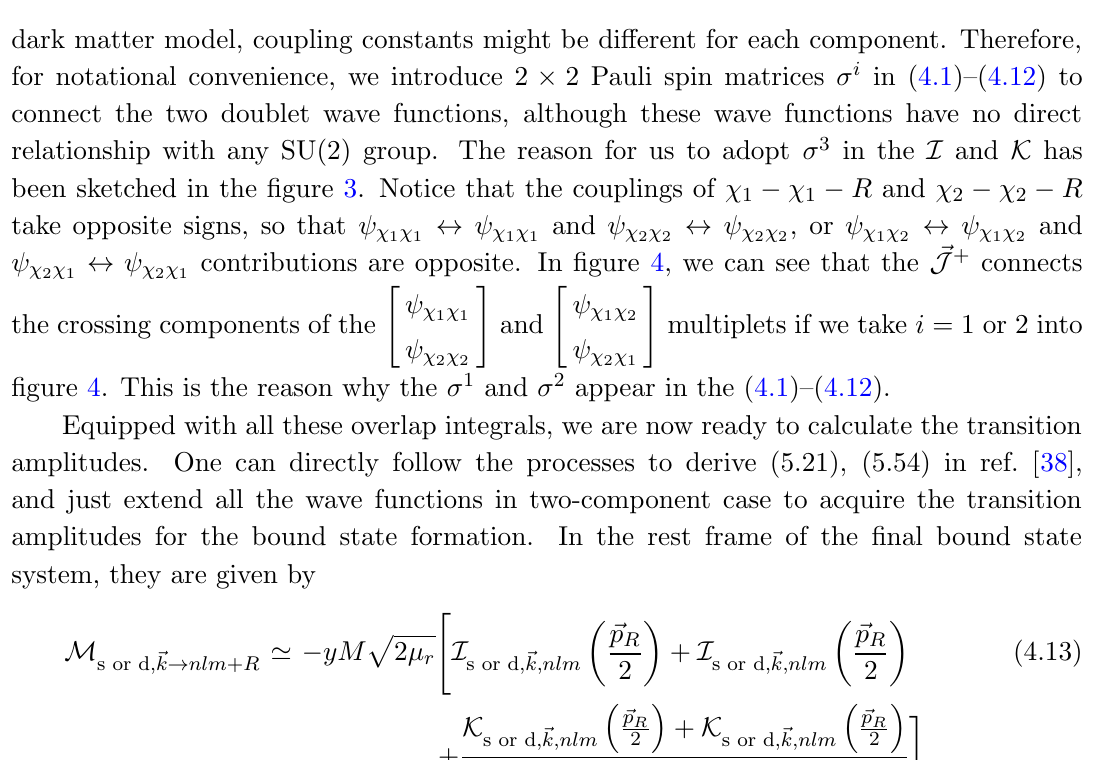
Figure 3 . Sketch diagrams emitting a R scalar boson. Notice that since the (cid:31) 1 (cid:31) 1 R and (cid:31) 2 (cid:31) 2 R couplings take di(cid:11)erent sighs, so the (cid:31) (cid:3) opposite